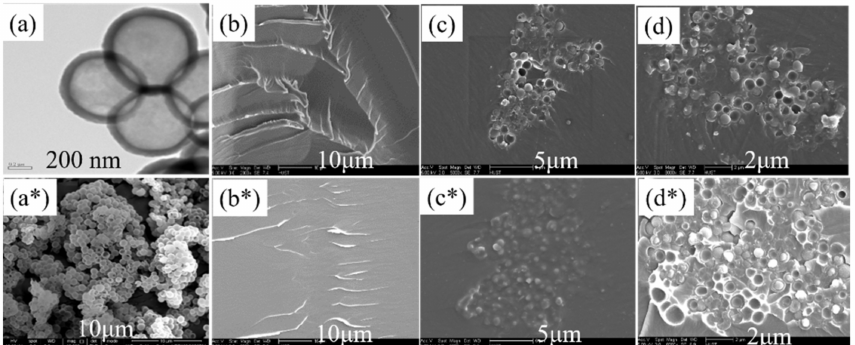
Figure 3. ( a ) TEM image of the HPS, ( a* ) SEM image of the HPS, ( b , b* ) SEM images of the fracture surface of EP and PEG/EP, ( c , c* ) SEM images of the HPS/EP and HPS/PEG/EP composites with the same HPS loading of 8 vol%, ( d , d* ) SEM images of the HPS/EP and HPS/PEG/EP composites with the same HPS loading of 24